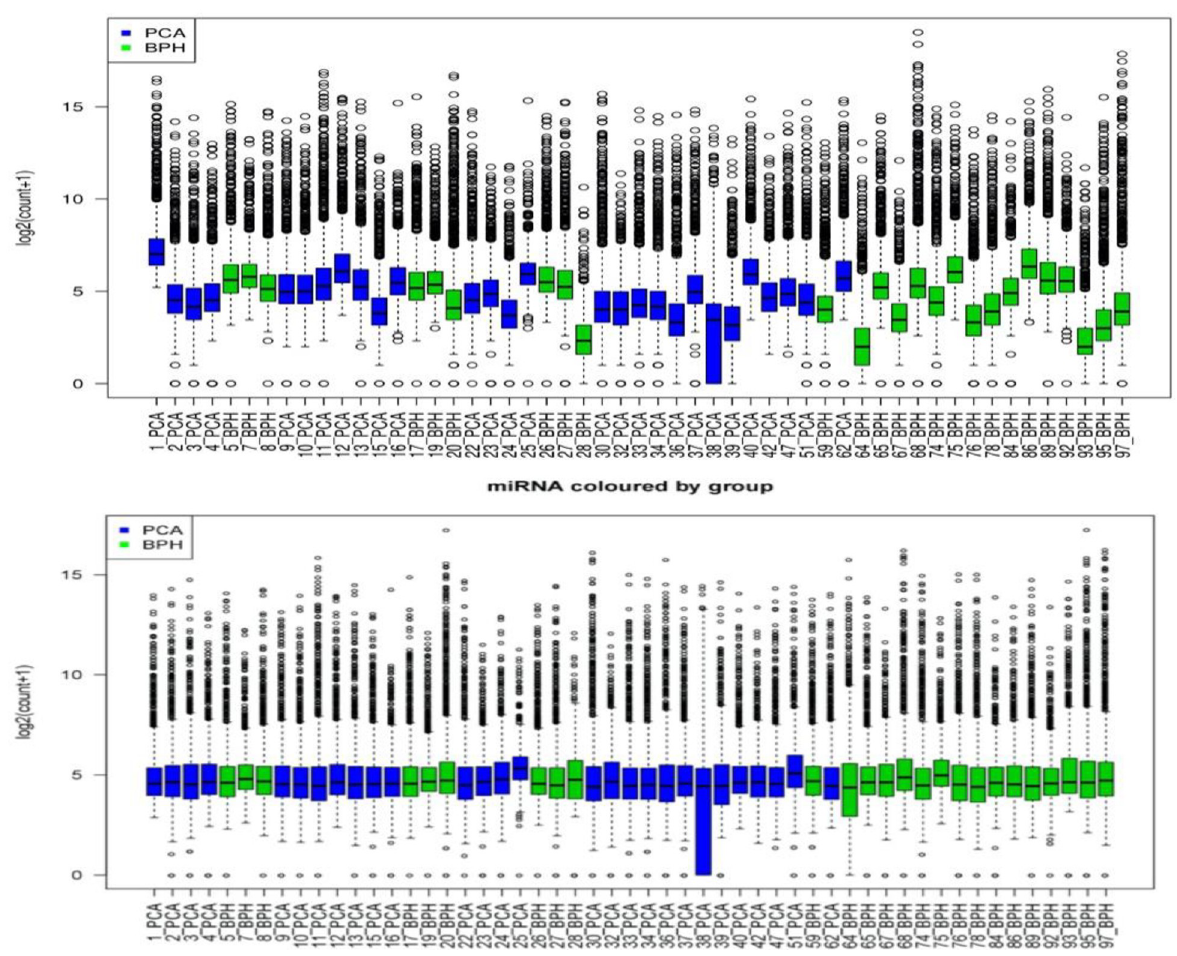
Fig 1. Distribution of miRNAs/pat. Before (top) and after (bottom)